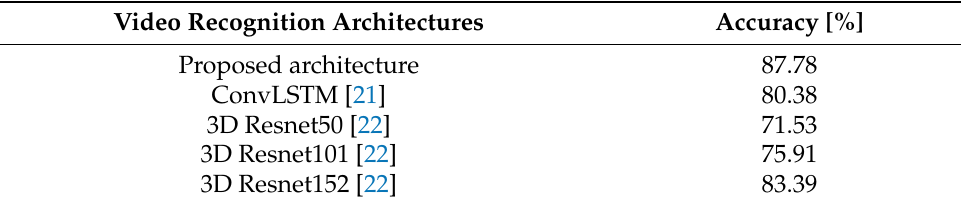
Table 8. Accuracy comparison of the proposed architecture with various neural network architectures using the UCF50mini